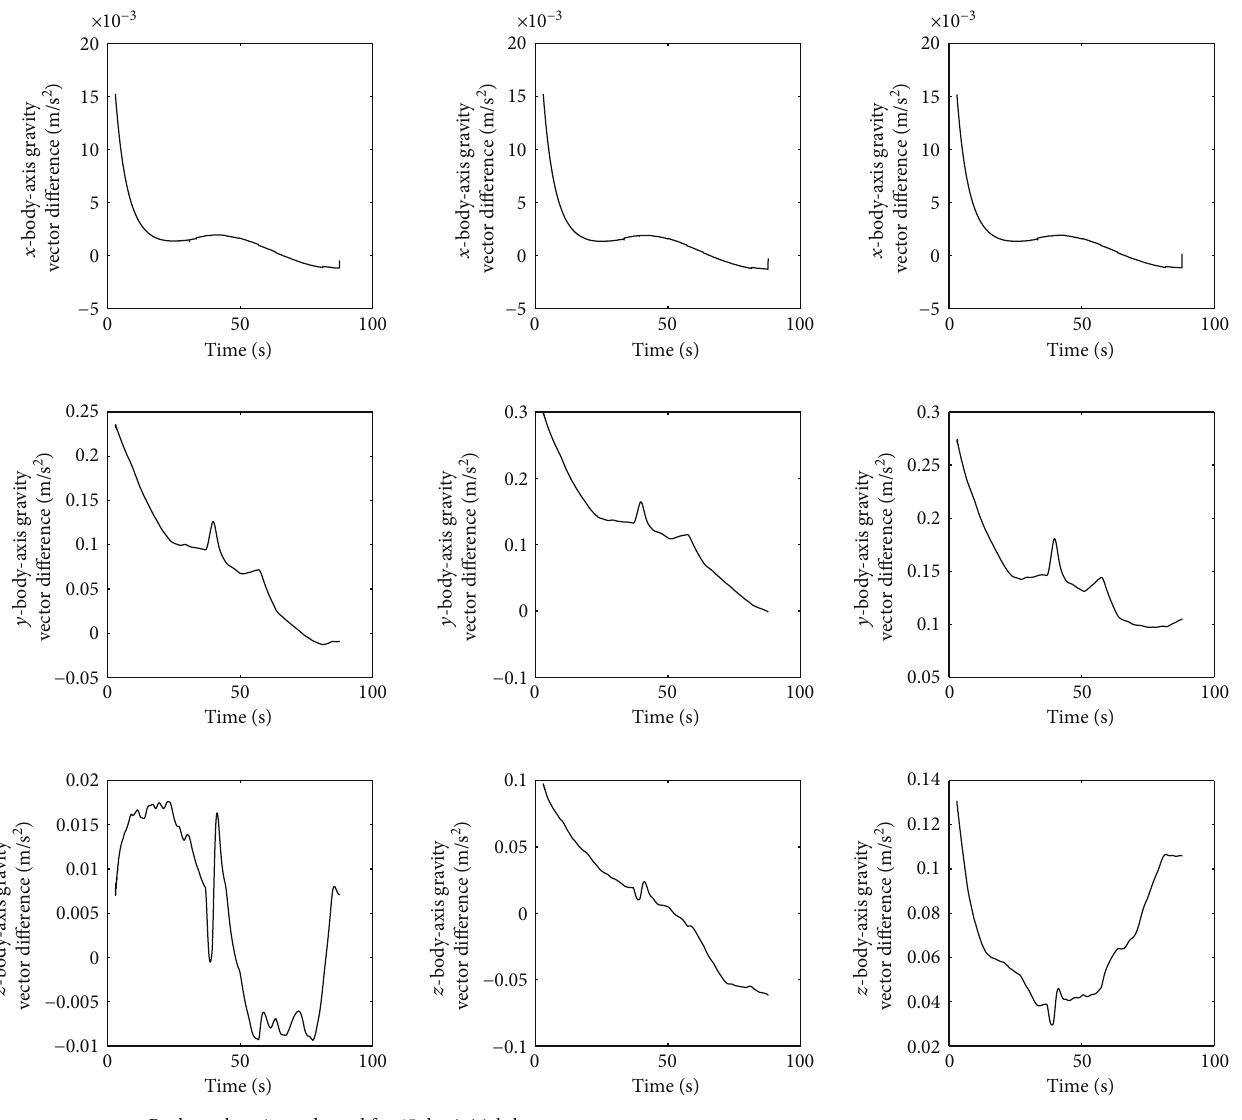
Figure 3: Comparison between estimated and real magnitudes for gravity vector for a shot angle of 45deg and azimuths of 0 ° (left), 45 ° (center), and 90 °